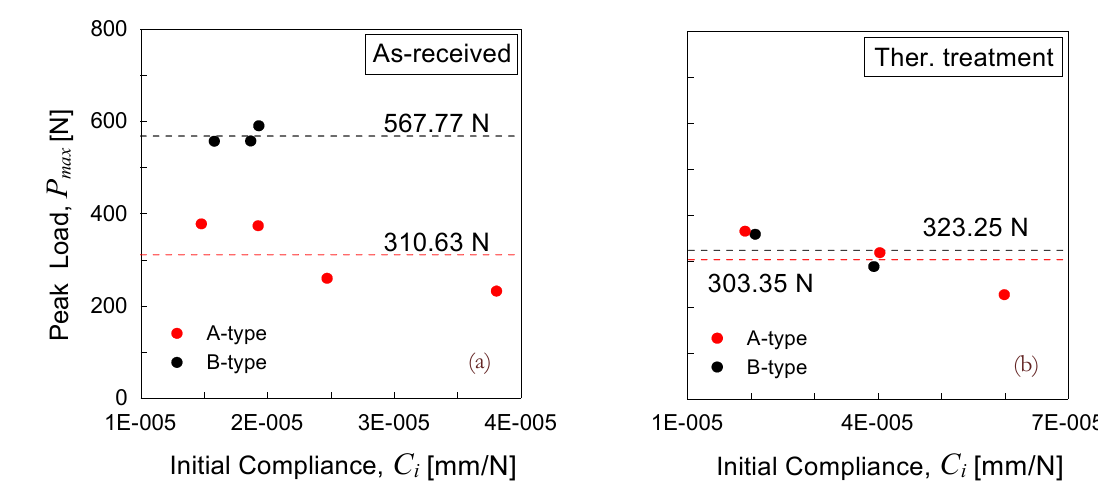
Figure 3: Peak load against initial compliance for: (a) the as-received and (b) the thermal pre-treated specimens.